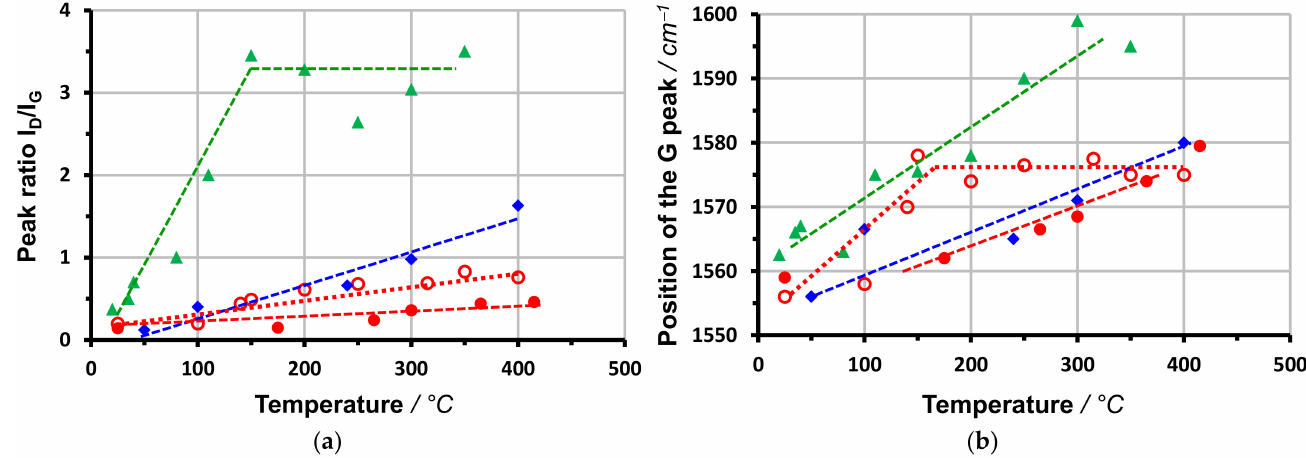
Figure 24. Variation of the Raman characteristics for carbon films in dependence on the deposition temperature. Data from [62,88] (green triangles, cathodic Laser-Arc deposition with ion energies of 80–90 eV), from [87] (red circles, filtered arc deposition with ion energies of 60 eV (empty symbols) and 100 eV (solid symbols) and from [86] (blue diamonds, filtered arc deposition with ion energies of 80 eV). ( a ) Raman peak ratio I D /I G . ( b ) Position of the G